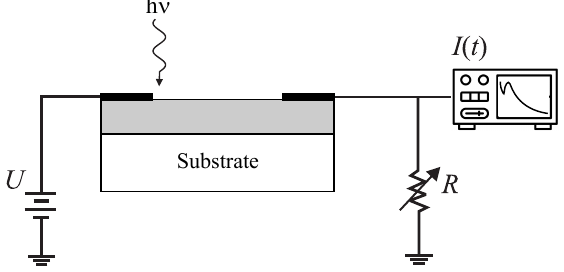
Figure 1. Schematic of the time-of-flight method in coplanar